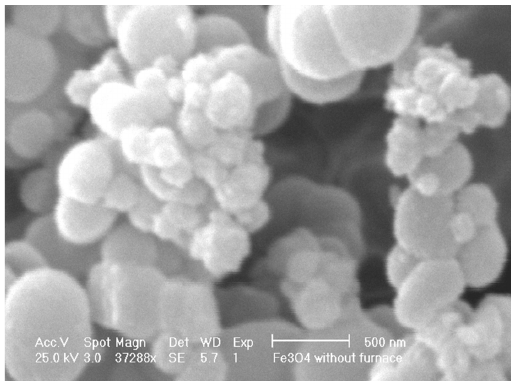
Fig. 1: SEM image of the Fe3O4 nanoparticles Fig.1:SEM image of the Fe 3 O 4 nanoparticles